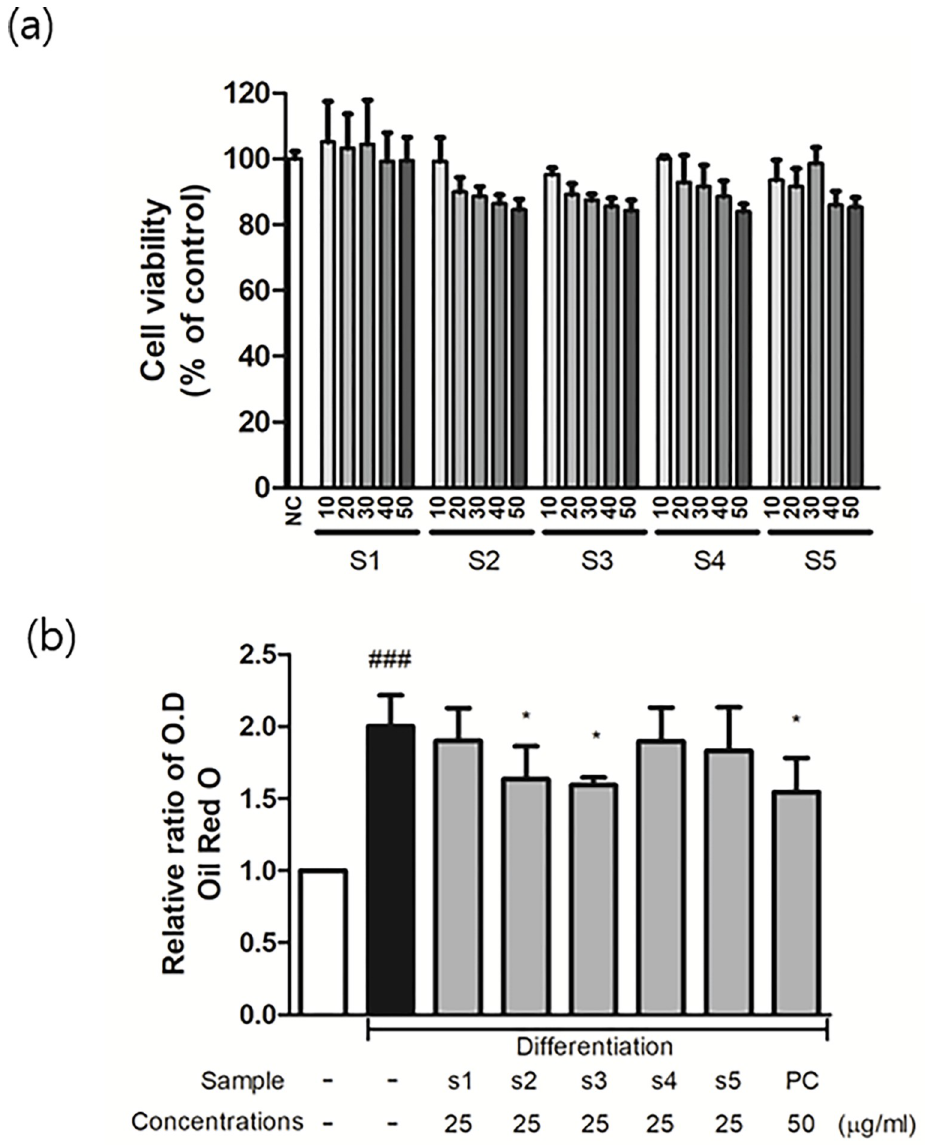
Fig 7. Effect of EH-CS combinations on 3T3-L1 preadipocytes and lipid contents of mature adipocytes. (a) Cell viabilities after treatment with EH-CS combinations (b) Oil Red O (ORO) staining results. Results are presented as the means ± SD of five different experiments. ###P < 0.001 versus non-differentiated 3T3-L1 preadipocytes, and � P < 0.05 versus differentiated adipocytes.